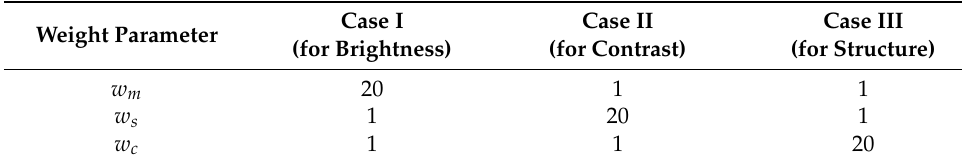
Table 6. Weight parameters for the brightness, contrast, and structure of